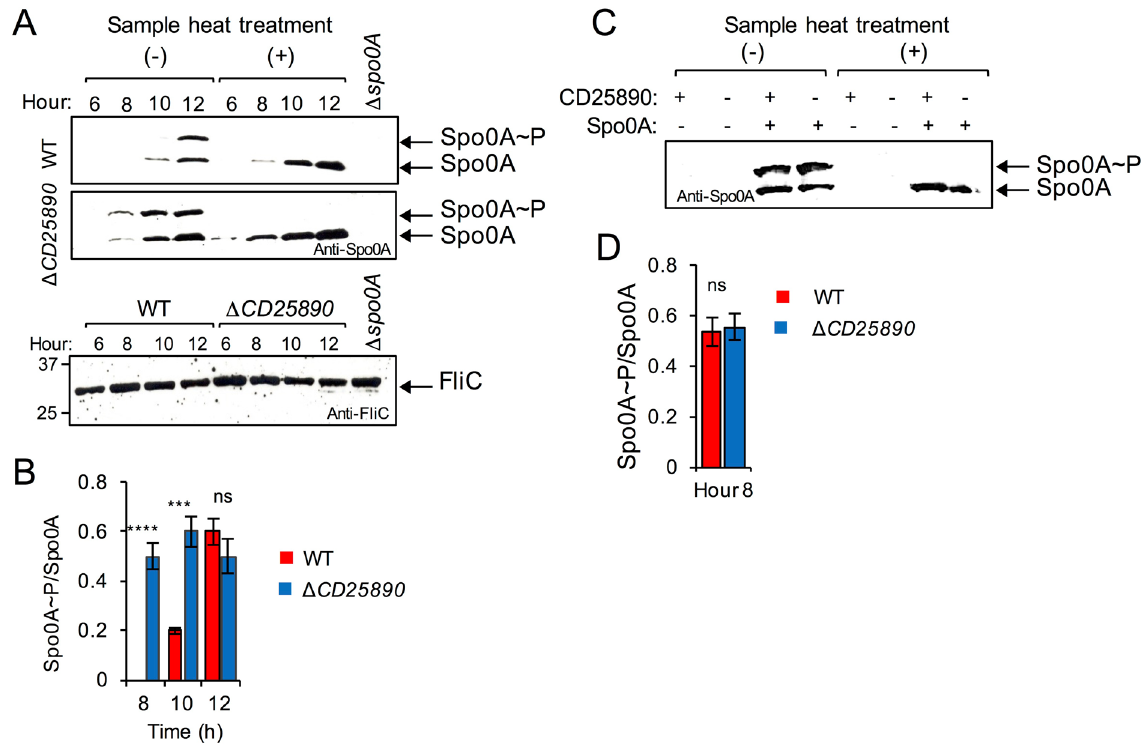
Figure 5. Phosphorylation of Spo0A in the (cid:31) CD25890 mutant. ( A ) Samples were collected from the WT and the (cid:31) CD25890 mutant grown in liquid SM, at the indicated times after inoculation. Extracts were prepared and proteins (15 µg) resolved by Phos-tag SDS-PAGE and subjected to immunobloting using an anti-Spo0A antibody. In the bottom panel the same extracts were loaded in a SDS-PAGE and subjected to immunoblotting using an anti- FliC antibody, as a loading control. The position of molecular weight markers (in kDa) is indicated on the left side of the panels. ( B ) and ( D ): The ratio of Spo0A ~ P to Spo0A was assessed with Image J software and represented for the WT and the (cid:31) CD25890 mutant at the indicated times (in hours) after inoculation in liquid SM. All data represent the means ± SD from three independent experiments. Asterisks indicate statistical significance determined by two-tailed Student t-test (ns, no significant; **** p < 0.0001, *** p < 0.001). C: Extracts were prepared from liquid SM cultures of the P tet - spo0A and (cid:31) CD25890 P tet - spo0A strains grown in the presence (50 nM) or in the absence of anhydrotetracycline, 8 h after inoculation. Proteins (15 µg) were resolved by Phos-tag SDS-PAGE and subject to immunoblotting using an anti-Spo0A antibody. In A and ( C ) The faster migrating bands (black arrows) show the unphosphorylated form of Spo0A (Spo0A), and the slower migrating bands indicate the phosphorylated form of Spo0A (Spo0A ~ P). The samples heated at 100 °C for 5 min were loaded as a control for the position of unphosphorylated cycline (ATc) responsive P tet promoter 48 . This experimental setup allows Spo0A to accumulate to similar levels in the wild-type and in the CD25890 mutant strain, and to test whether Spo0A ~ P accumulated to a higher level in the mutant. The strains were grown in SM supplemented with 50 nM of ATc, a concentration at which Spo0A accumulates to levels similar to the wild-type strain 48 , and proteins in whole cells extracts were resolved by Phos- tag SDS-PAGE (Fig. 5C). In both strains Spo0A accumulated at similar levels and the Spo0A ~ P/Spo0A ratio was similar (Fig. 5C,D). In agreement with this observation, we found no difference in the titer of heat resistant spores produced by both strains (Table S2). These results suggest that CD25890 acts to decrease the levels of spo0A transcription per cell. Since CD25890 has a putative DNA-binding domain (DUF 1732; Fig. 1), this effect may be direct or indirect. Deletion of CD25890 influences the expression of the sinRR’ operon. To determine whether the CD25890 mutation had a more generalized effect on gene expression, we decided to compare the transcrip- tome of the mutant with the wild type after 10 h of growth in SM. We used two biological replicates and genes were considered differentially expressed if the fold change was > 2 and the adjusted p value < 0.01. 165 genes were overexpressed in the mutant, while only 21 genes were down-regulated (Table S3). From the upregulated genes, 69% of genes are regulated by Spo0A or by sporulation-specific cell type-specific sigma factors (Fig. 6A and Table S3). In contrast, no sporulation genes were found among the downregulated genes (Table S3). No toxin, biofilm or motility genes were among the genes differentially expressed in the CD25890 mutant (Table S3). However, the sinRR’ operon showed increased expression in the CD25890 mutant (~ fivefold, relative to the wild type; Table S3). The sinRR’ operon was previously shown to be involved in sporulation, toxin production and motility 25 . Overexpression of sinR increased sporulation efficiency, while overexpression of sinR’ reduced